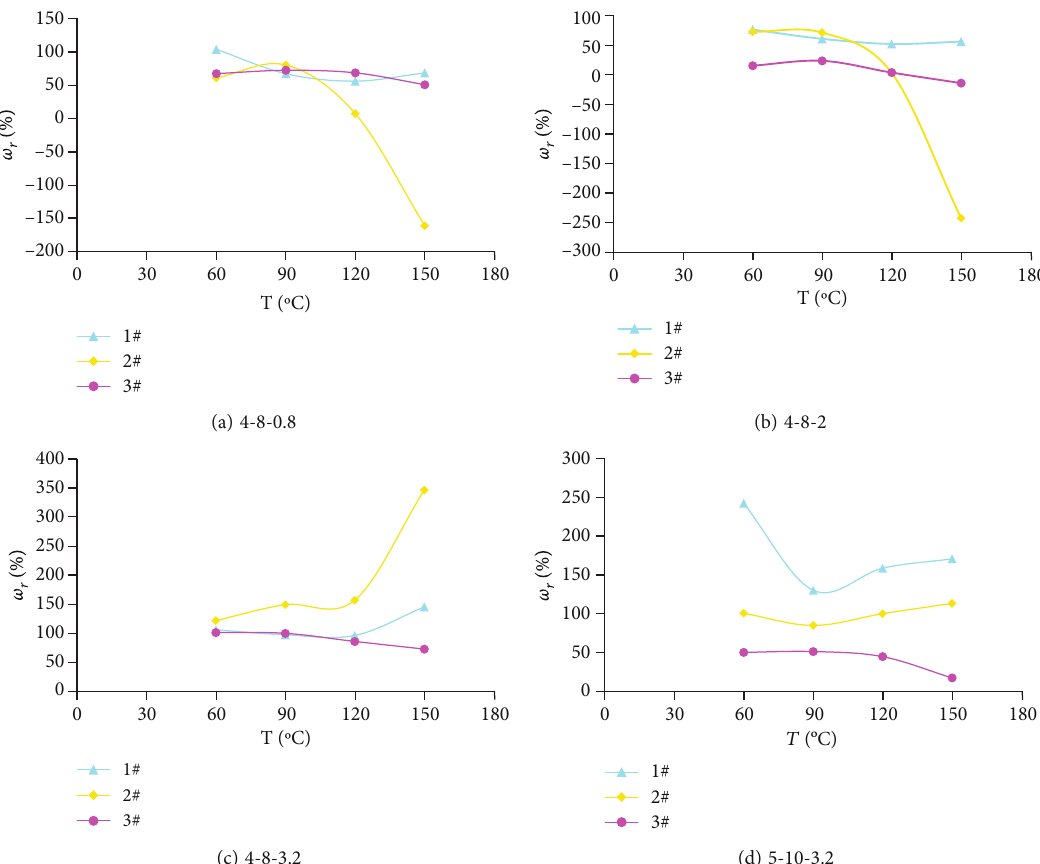
ff erent stress